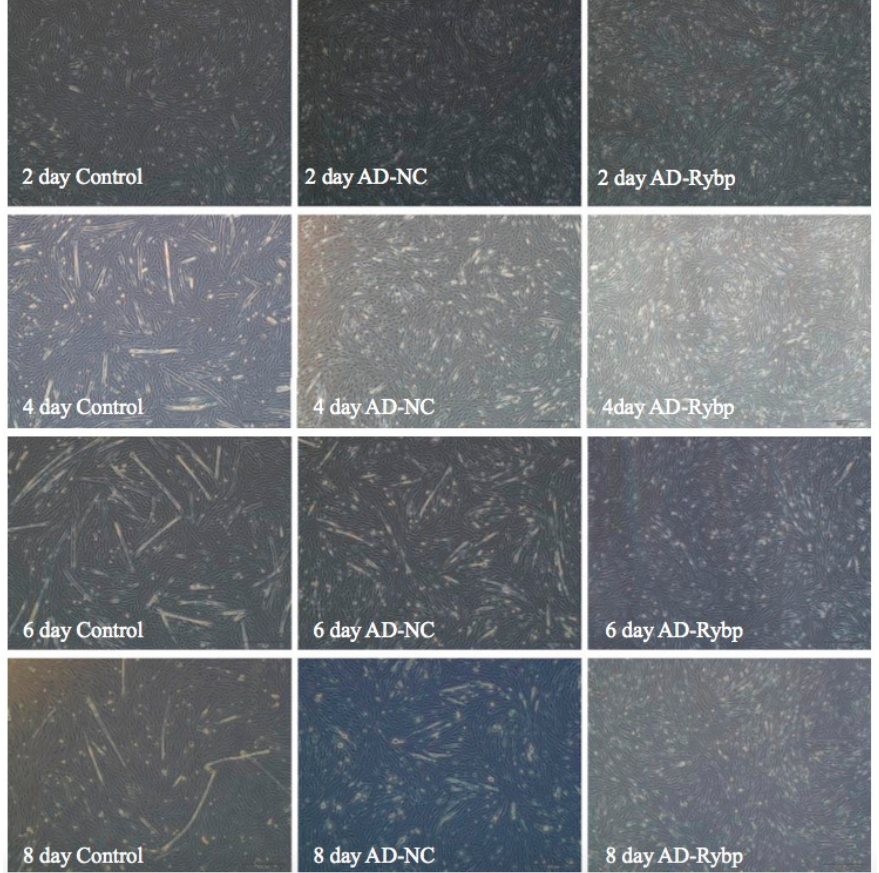
Figure 2. The morphologic changes of myoblasts at different differentiation times (2 days, 4 days, 6 days, and 8 days) after overexpressing the Rybp gene (40×). Note: the differences in myoblast fusion were visible after 4 days of treatment; the AD-Rybp cells were poorly fused (fewer and shorter myotubes) compared to cells with added negative control adenoviruses (AD-NC) or the control group.